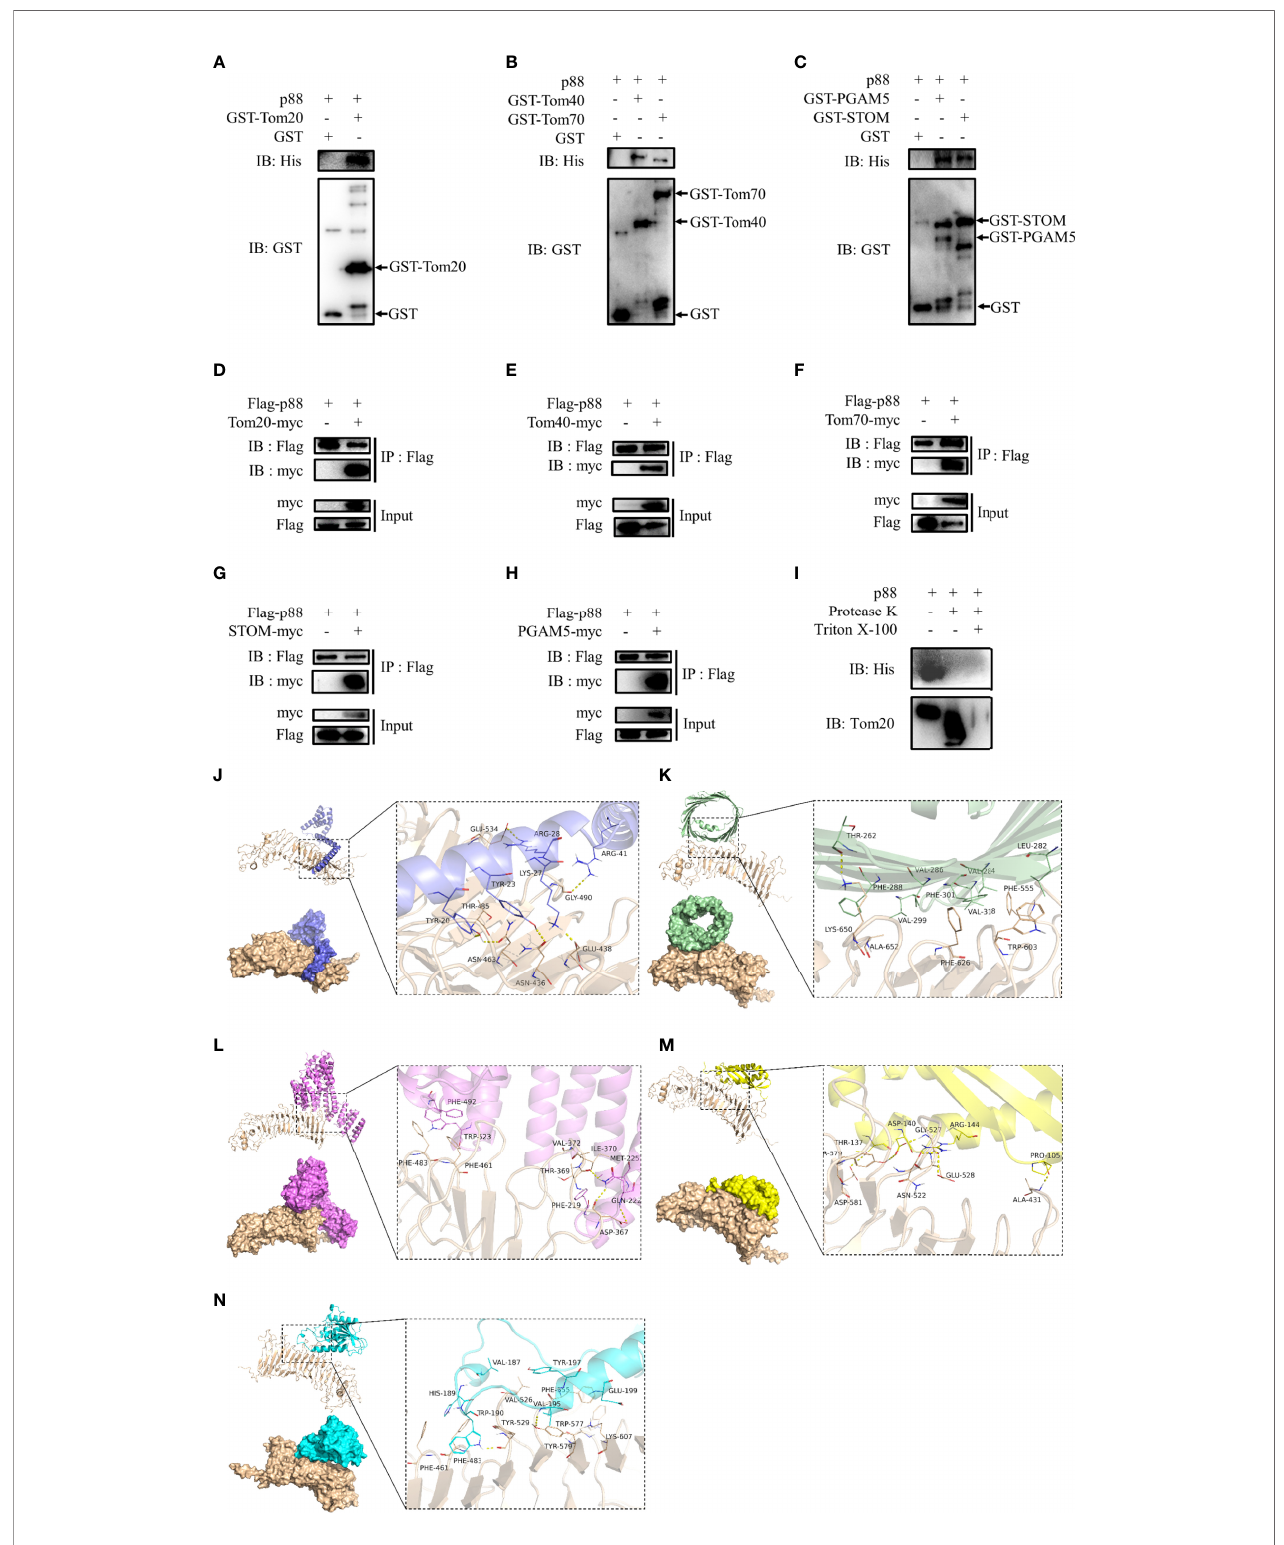
FIGURE 8 | Proteins interacting with VacA. The combination of GST pull-down and western blot was used to detect interactions of Tom20 (A) , Tom40 (B) , Tom70 (B) , STOM (C) , and PGAM5 (C) with p88 (VacA). Co-immunoprecipitation experiments were carried out to further verify these interactions (D-H) . Protease K assays were performed to determine interactions of Tom20 and p88 (I) . Tom20 (J) , Tom40 (K) , Tom70 (L) , STOM (M) , and PGAM5 (N) were imported into ZDOCK to simulate possible